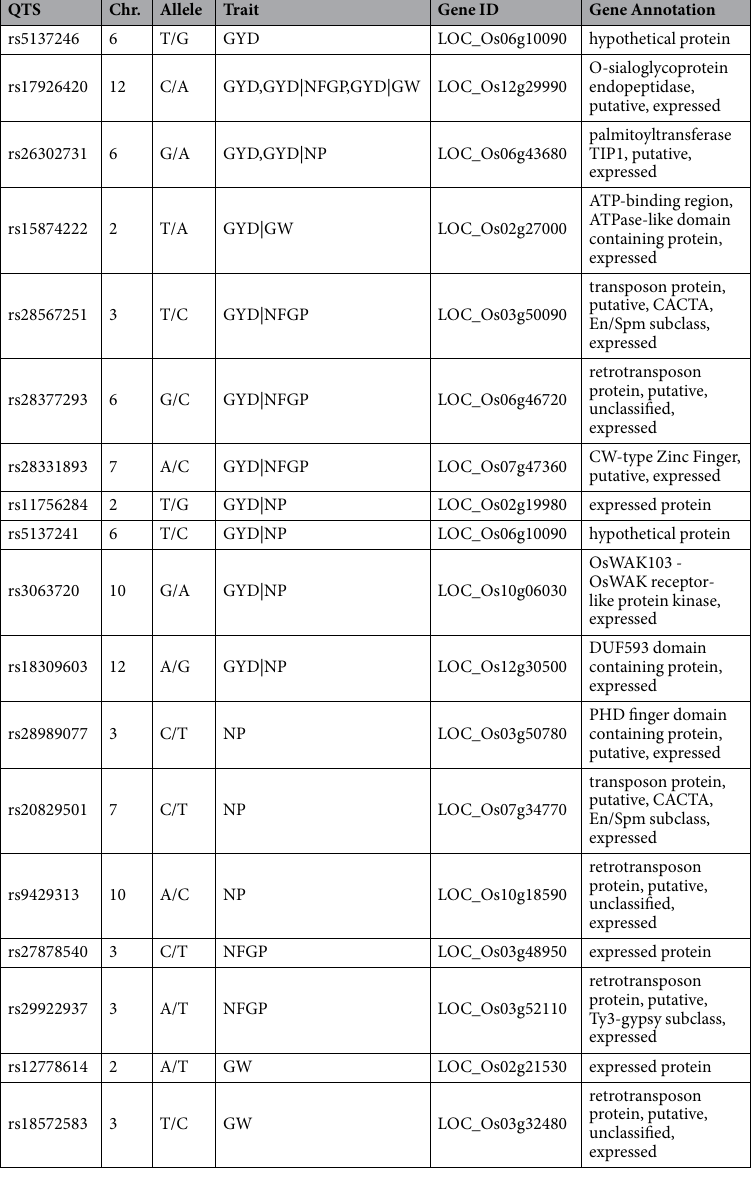
Table 5. Detected significant SNPs located within annotated genes. Note: Gene annotation information comes from the database: MSU Rice Genome Annotation Project Release 7,